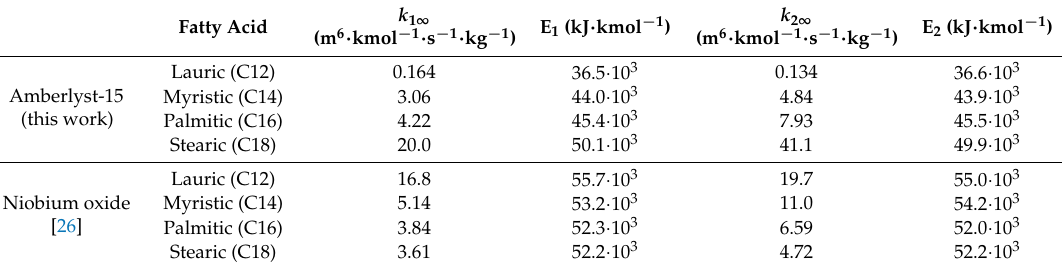
Table 1. Kinetic parameters for the esterification of fatty acids with